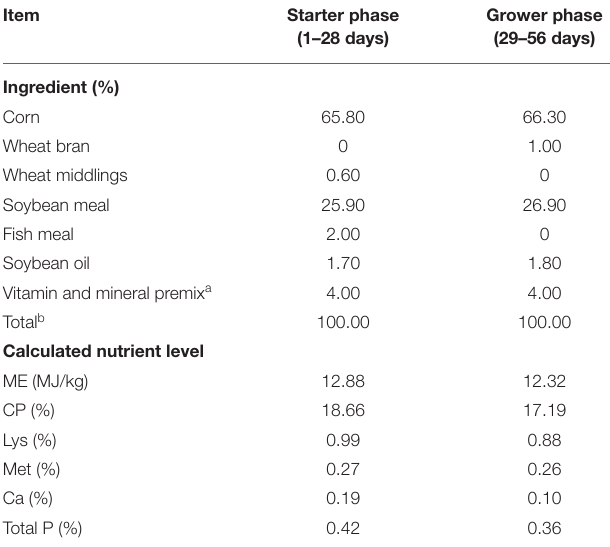
TABLE 1 | Diet composition and nutrient levels (as-fed basis,